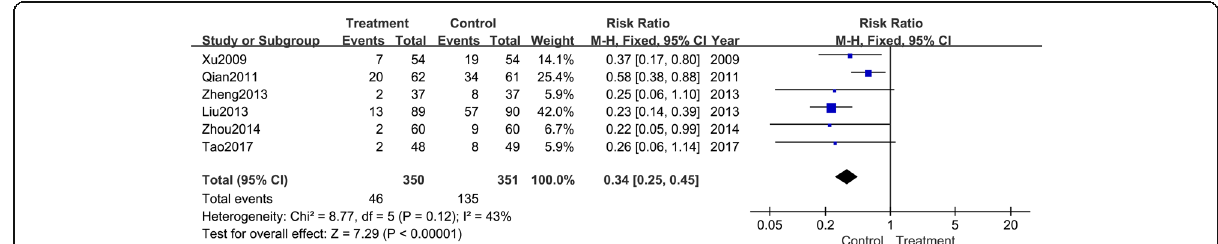
Fig. 10 Meta-analysis of recurrence rates during follow-up. CI indicates confidence